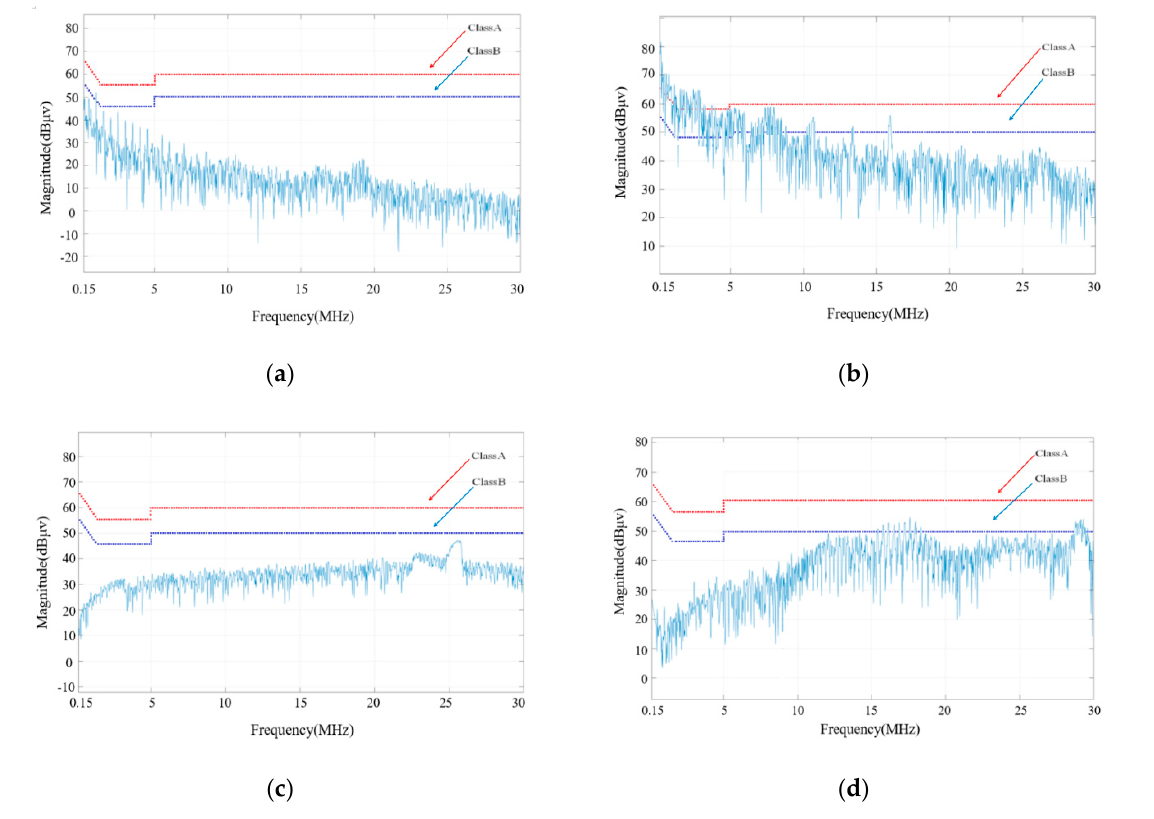
Figure 15. Common-mode (CM) interference simulation diagram: ( a ) common mode interference on AC side of infinite element method; ( b ) common mode interference on DC side of infinite element method; ( c ) CM interference on the AC side of the rectifier system discussed in this paper; ( d ) CM interference on the DC side of the rectifier system discussed in this paper.